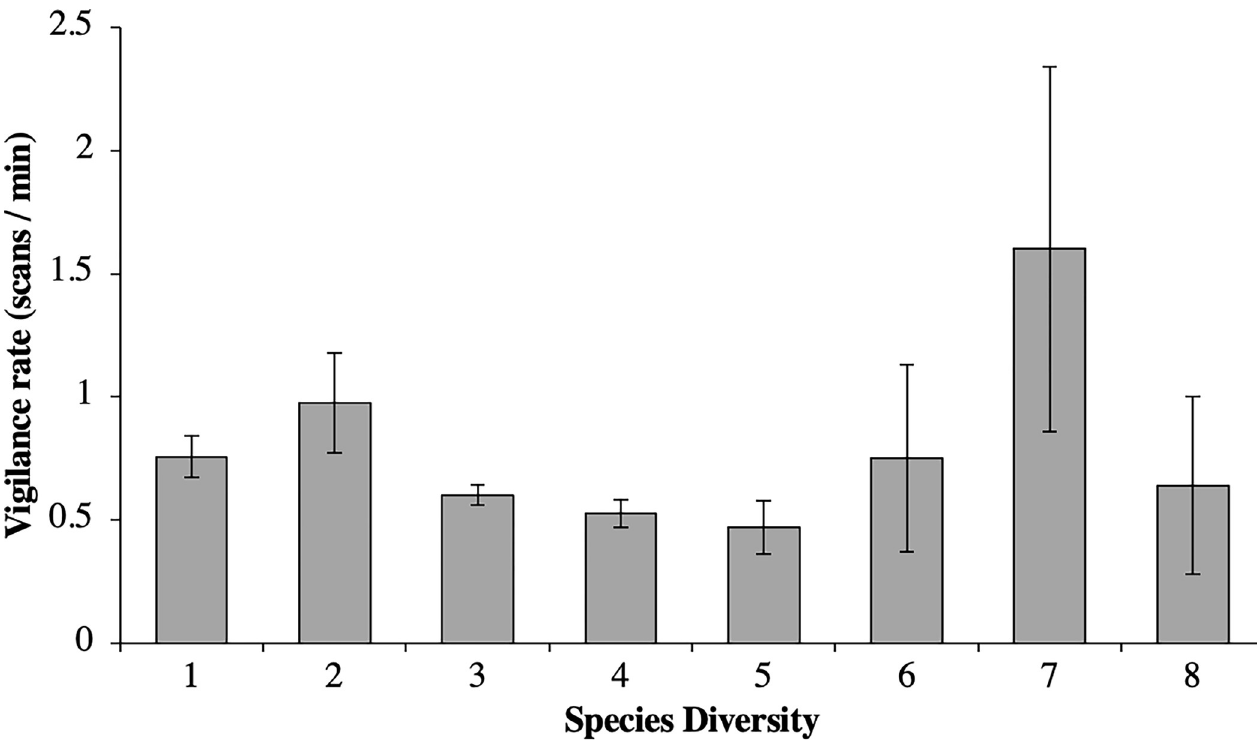
Fig 2. Mean rate of vigilance (number of scans per minute) across different species diversities (number of different species present in the environment). in the wild (11.1%) than in the zoo (1.4%), (W(327) = 13760, p < 0.001). Less time was spent resting in the wild (5.4%) compared to the zoo (28%), (W(327) = 6619.5, p < 0.001), and more time locomoting in the wild (25.6%) than the zoo (8.5%), (W(327) = 12854, p = 0.002). More time was spent on self-maintenance in the wild (5.3%) than in the zoo (1.1%), (W(327) = 12004, p = 0.021). There was no difference in the proportion of time spent vigilant in the wild (19.9%) compared to the zoo (19.0%), (W(327) = 10750, p = 0.788). More time was spent affili- ating in the zoo (2.7%) than in the wild (1.4%), (W(327) = 8559, p < 0.001) but there was no Table 6. Coefficients and p-values for the negative binomial GLMM investigating the influence of habitat type, feeding ecology, body size, time of day, total animals present, and species diversity on rates of vigilance in the zoo. Fixed effect